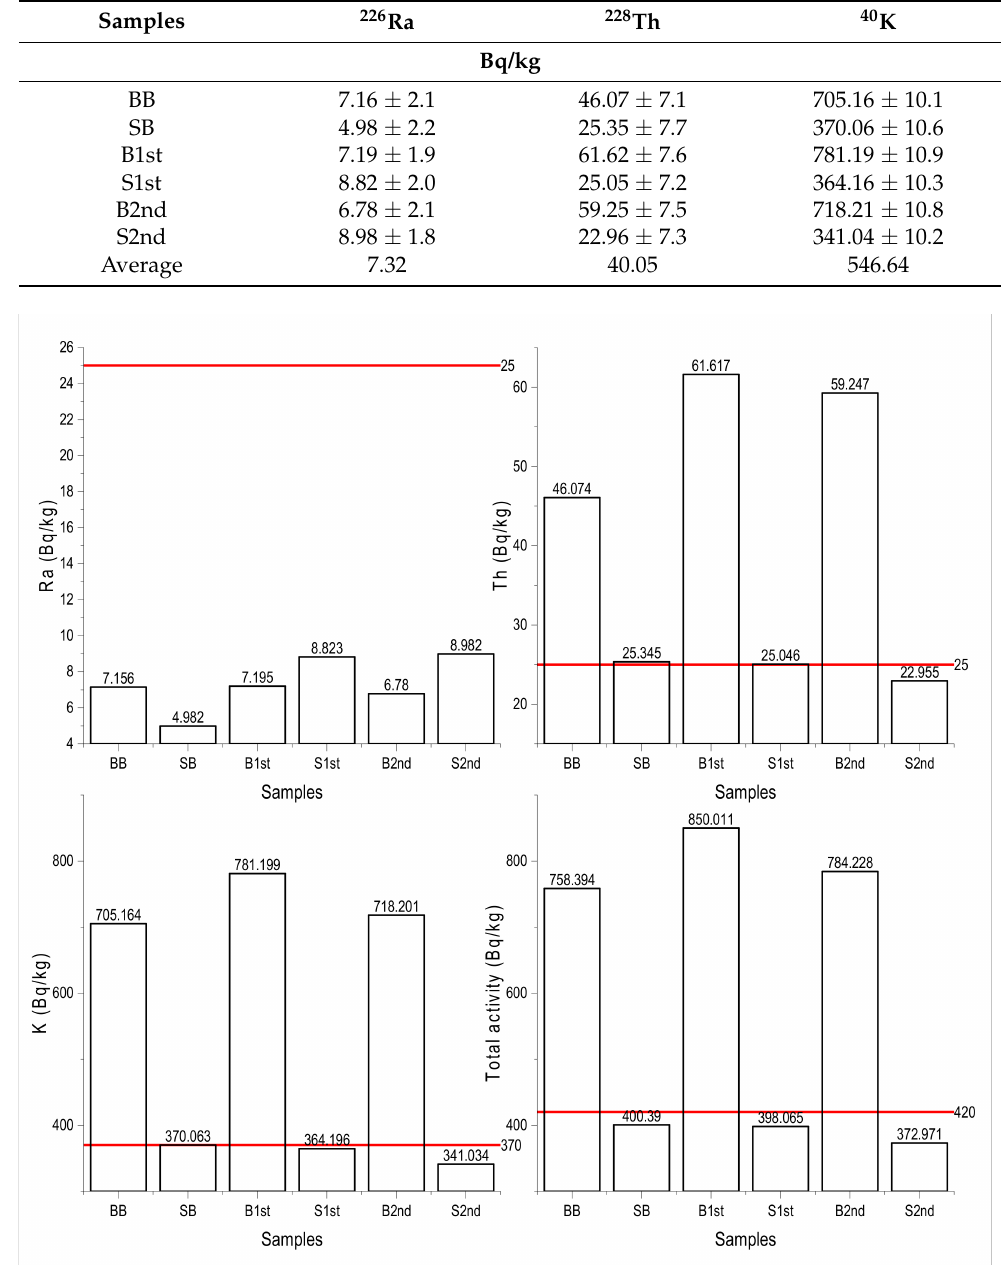
Figure 6. Comparison of measured activity concentrations of 226 Ra, 232 Th, and 40 K in building material samples with the world average concentrations (represented by red lines). As assumed, the measured concentrations of 40 K were almost twice as high in brick samples than in stone